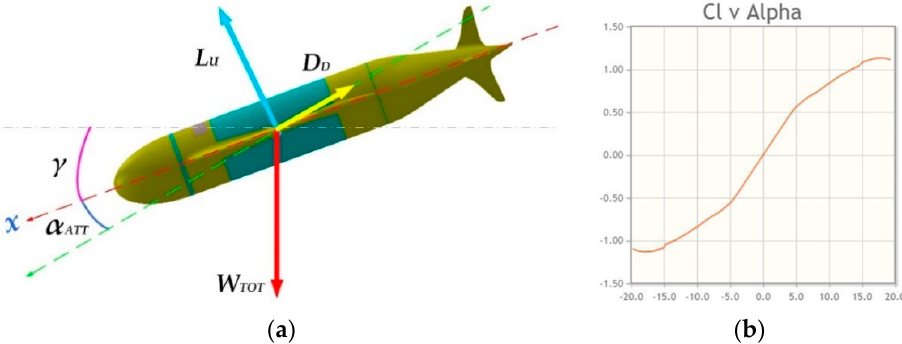
Figure 7. Dynamic balance of the forces ( a ) Drone geometrical balance of the forces; ( b ) Cl vs. Alpha ( = angle of attack, α att ) diagram for Eppler E838 aerofoil